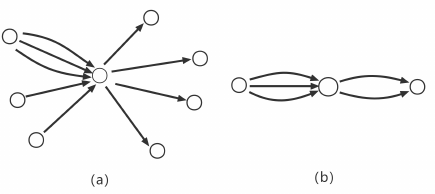
Figure 12. Misclassification samples: ( a ) is an example with few reverse interactions between nodes, and ( b ) is an example with a relatively small number of